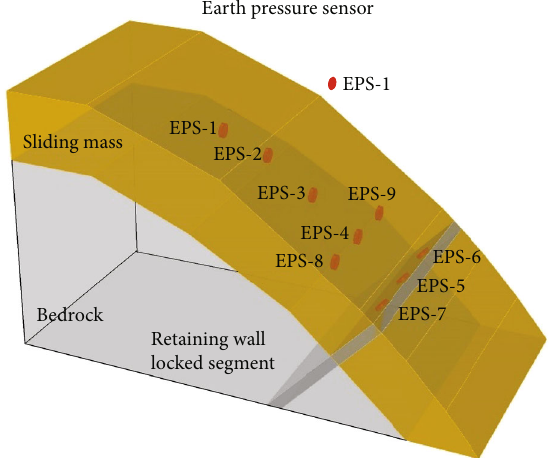
Figure 3: Locations of the earth pressure sensors (EPS).